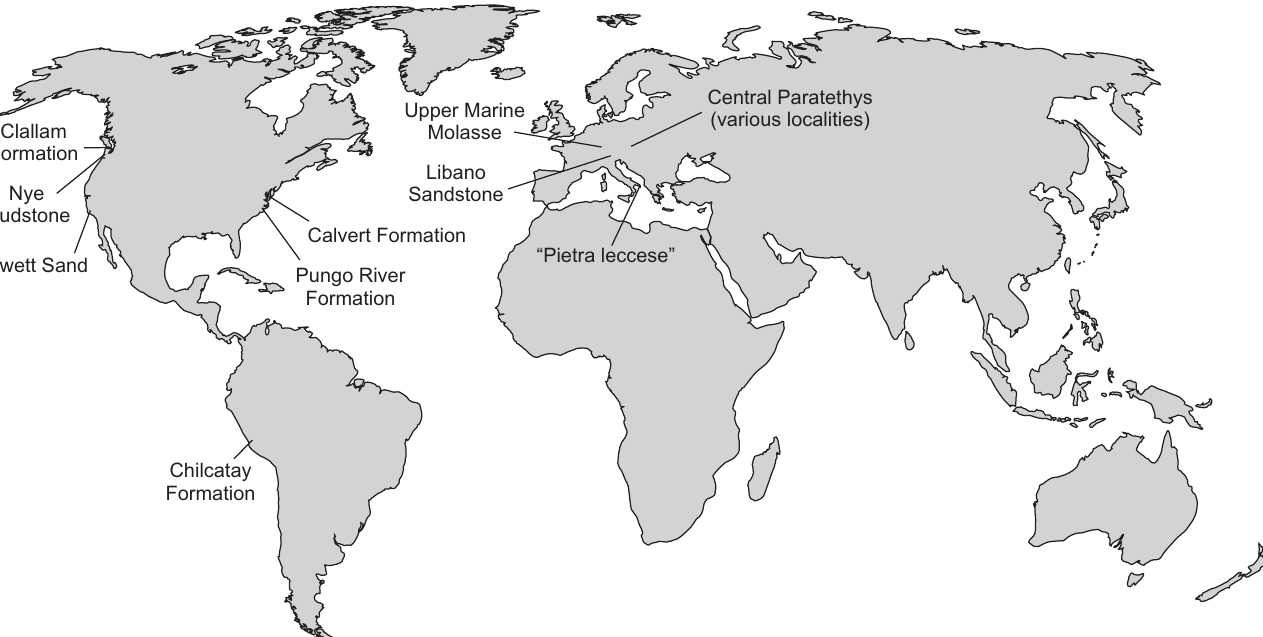
Fig. 1. Location of major formations that have yielded diverse odontocete assemblages, but few or no mysticetes. Sources: Clallam Formation, Nye Mudstone, and Jewett Sand (Barnes 1977; Crowley et al. 1999); Calvert Formation (Gottfried et al. 1994); Pungo River Formation (Whitmore and Kaltenbach 2008); Chilcatay Formation (Bianucci et al. 2018); Upper Marine Molasse (Pilleri 1986a, b); Libano Sandstone and ”Pietra leccese” (Bianucci and Landini 2002); Central Paratethys (Grigorescu and Kazár